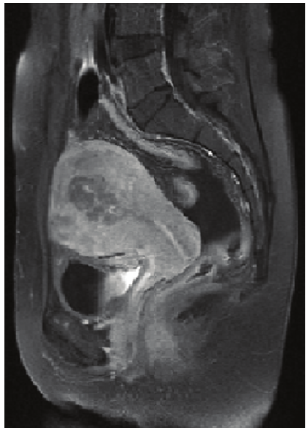
Figure 1: Pelvic MRI. Increase in diffuse thickness of uterus.